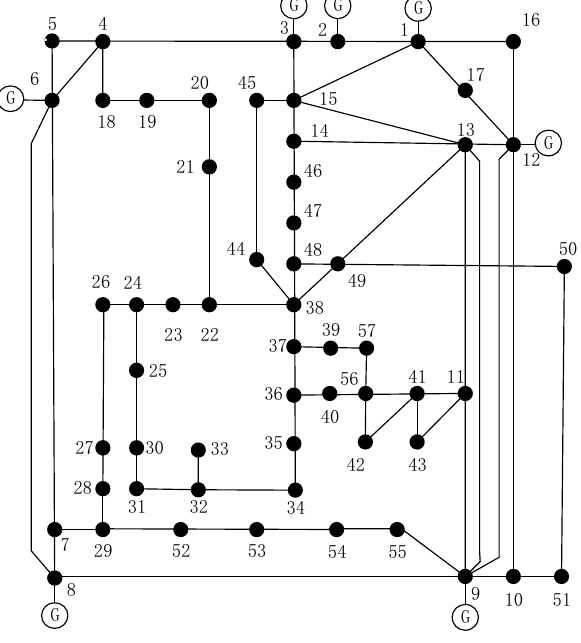
Figure 4. Structure of 57-bus microgrids.